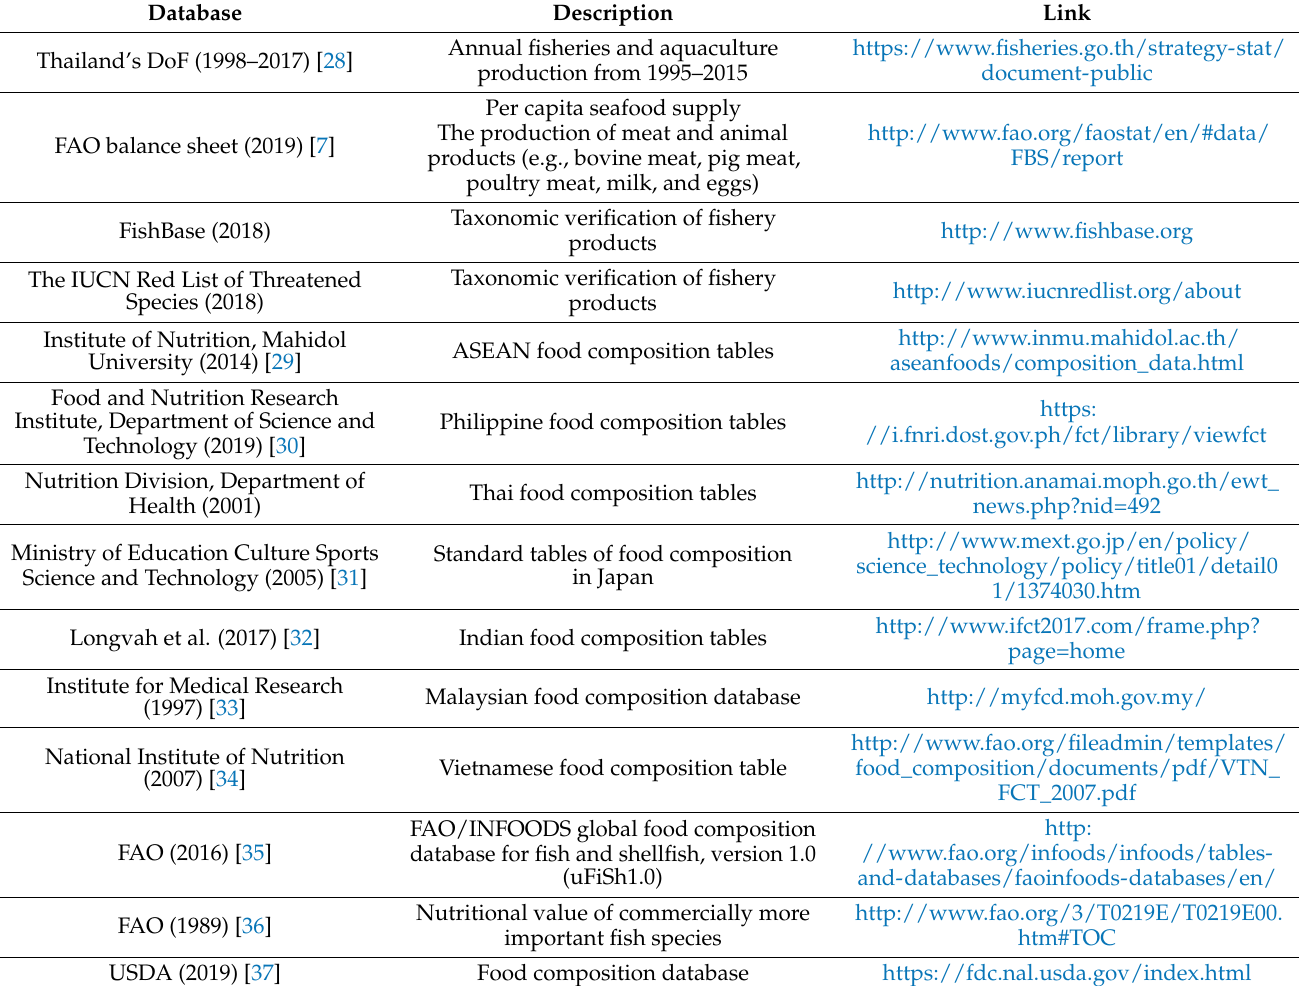
Table 1. Data sources. The webpages were all accessed on 14 January